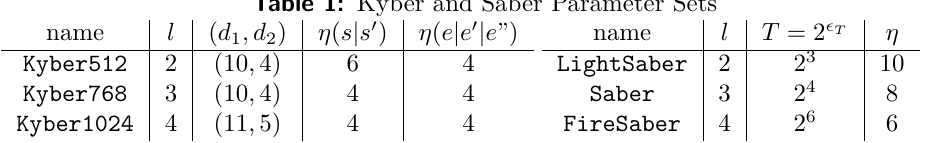
Table 1: Kyber and Saber Parameter